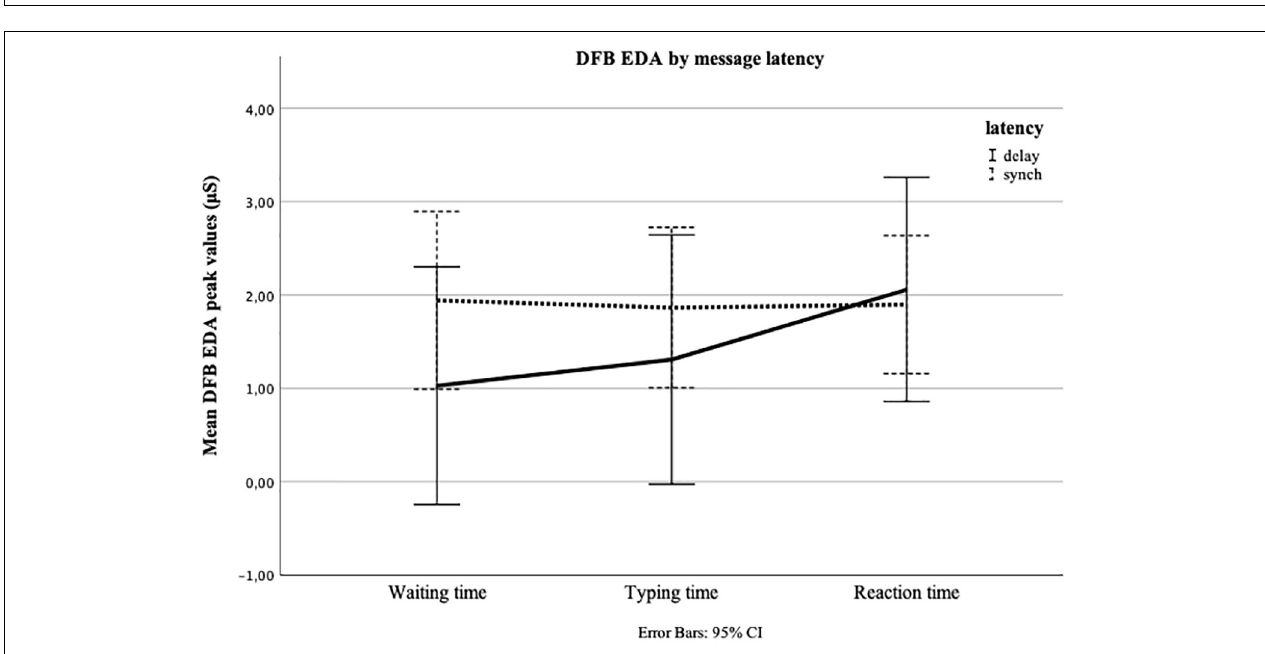
FIGURE 3 | Repeated measures of heart rate (HR) in beats per minute (BPM) for Waiting time, Typing time, and Reaction time by message latency (delay = 7 min Waiting time; synch = 1 min Waiting time). The y -axis shows the mean peak value calculated as a deviation from the baseline measure (DFB) for the final 30 s of Waiting time, the first 30 s of Typing time, and the first 30 s of Reaction time.